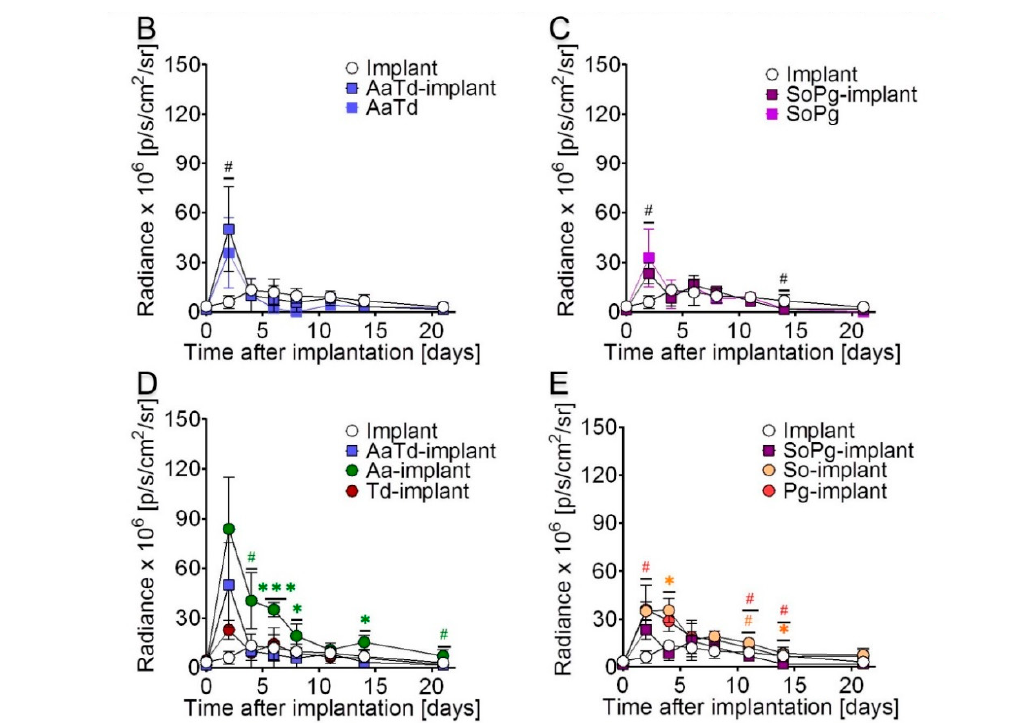
Figure 3. IFN- β induction upon dual species infections. ( A ) IFN- β luminescence measured at the indicated time points in days from sterile implants, infected implants ( + ), infected surgical pouches without implants ( − ). Bioluminescent images from a typical single experiment. Implantation sites were marked as region of interest and bioluminescent signals were quantified as radiance at the indicated time points ( B , C ). ( B ) IFN- β kinetics upon A. actinomycetemcomitans-T. denticola (AaTd) dual species infections of implants (blue squares with borders), tissues (blue squares). ( C ) IFN- β kinetics upon S. oralis-P. gingivalis (SoPg) dual species infections of implants (purple squares with borders), tissues (purple squares). ( D ) Comparison of Aa and Td implant infections as single species with AaTd dual species implant infections. ( E ) Comparison of So and Pg implant infections as single species with SoPg dual species infections. Three animals, each carrying three implants were used in each group yielding n = 9 biological observations. Error bars indicate mean ± s.e.m. Significance values have been adjusted by the Bonferroni correction for multiple tests. Symbols ***, *, and # indicate p < 0.001, p < 0.05, and significant p value prior to Bonferroni correction, respectively. Black symbols represent p values between sterile and infected implants ( B , C ). Colored symbols indicate p values between implants infected with single species to dual species infected implants ( D , E ).